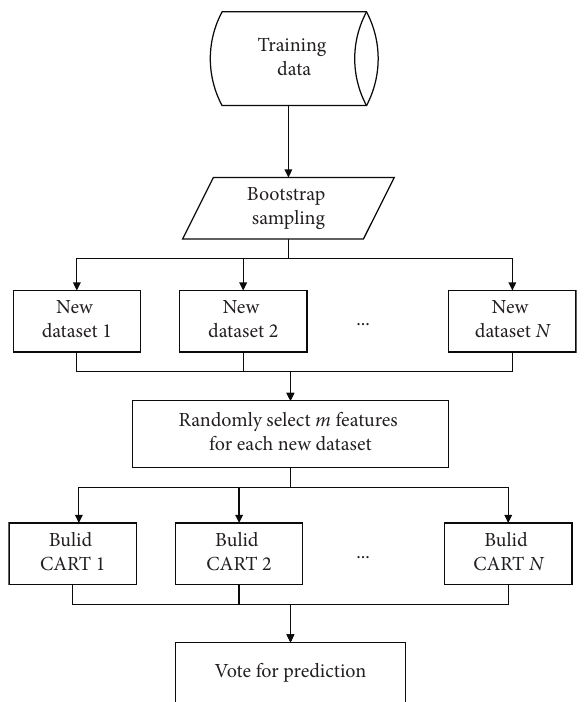
Figure 1: Flow chart of random